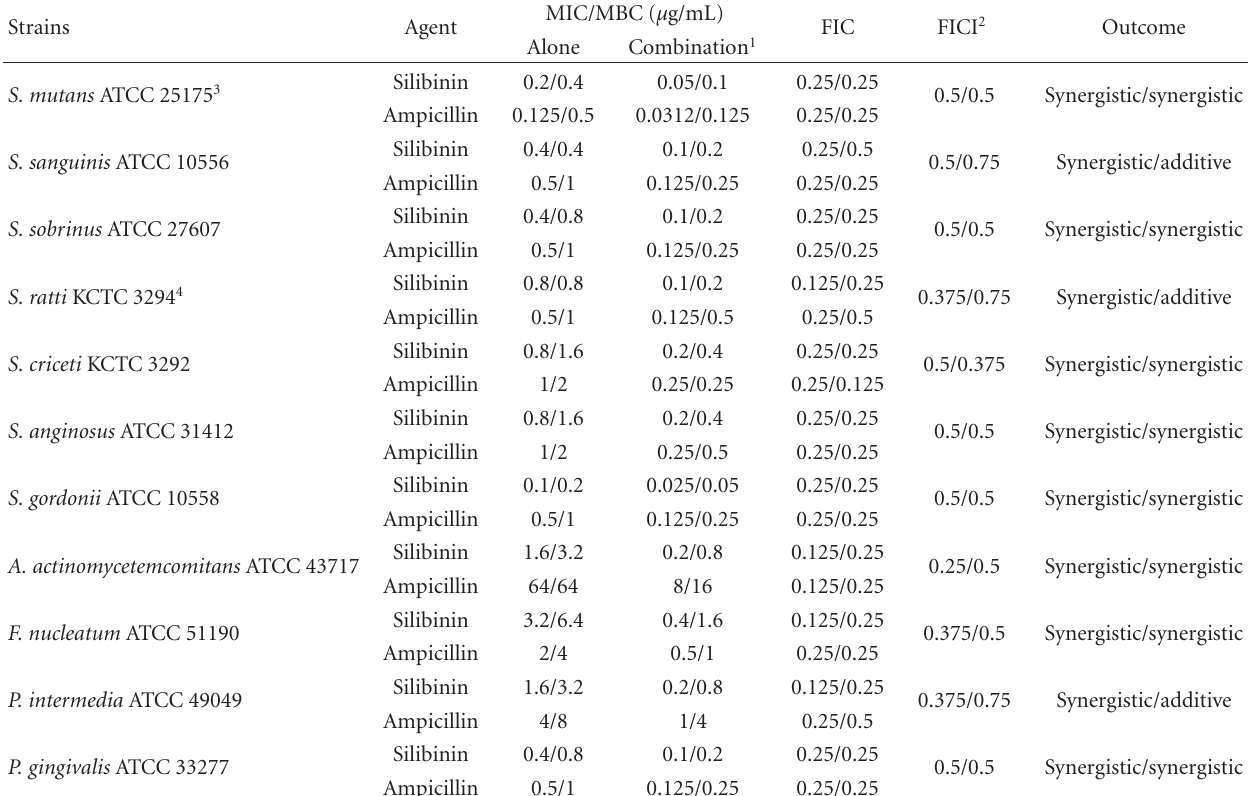
Table 2: Synergistic e ff ects of the silibinin with ampicillin against oral bacteria.